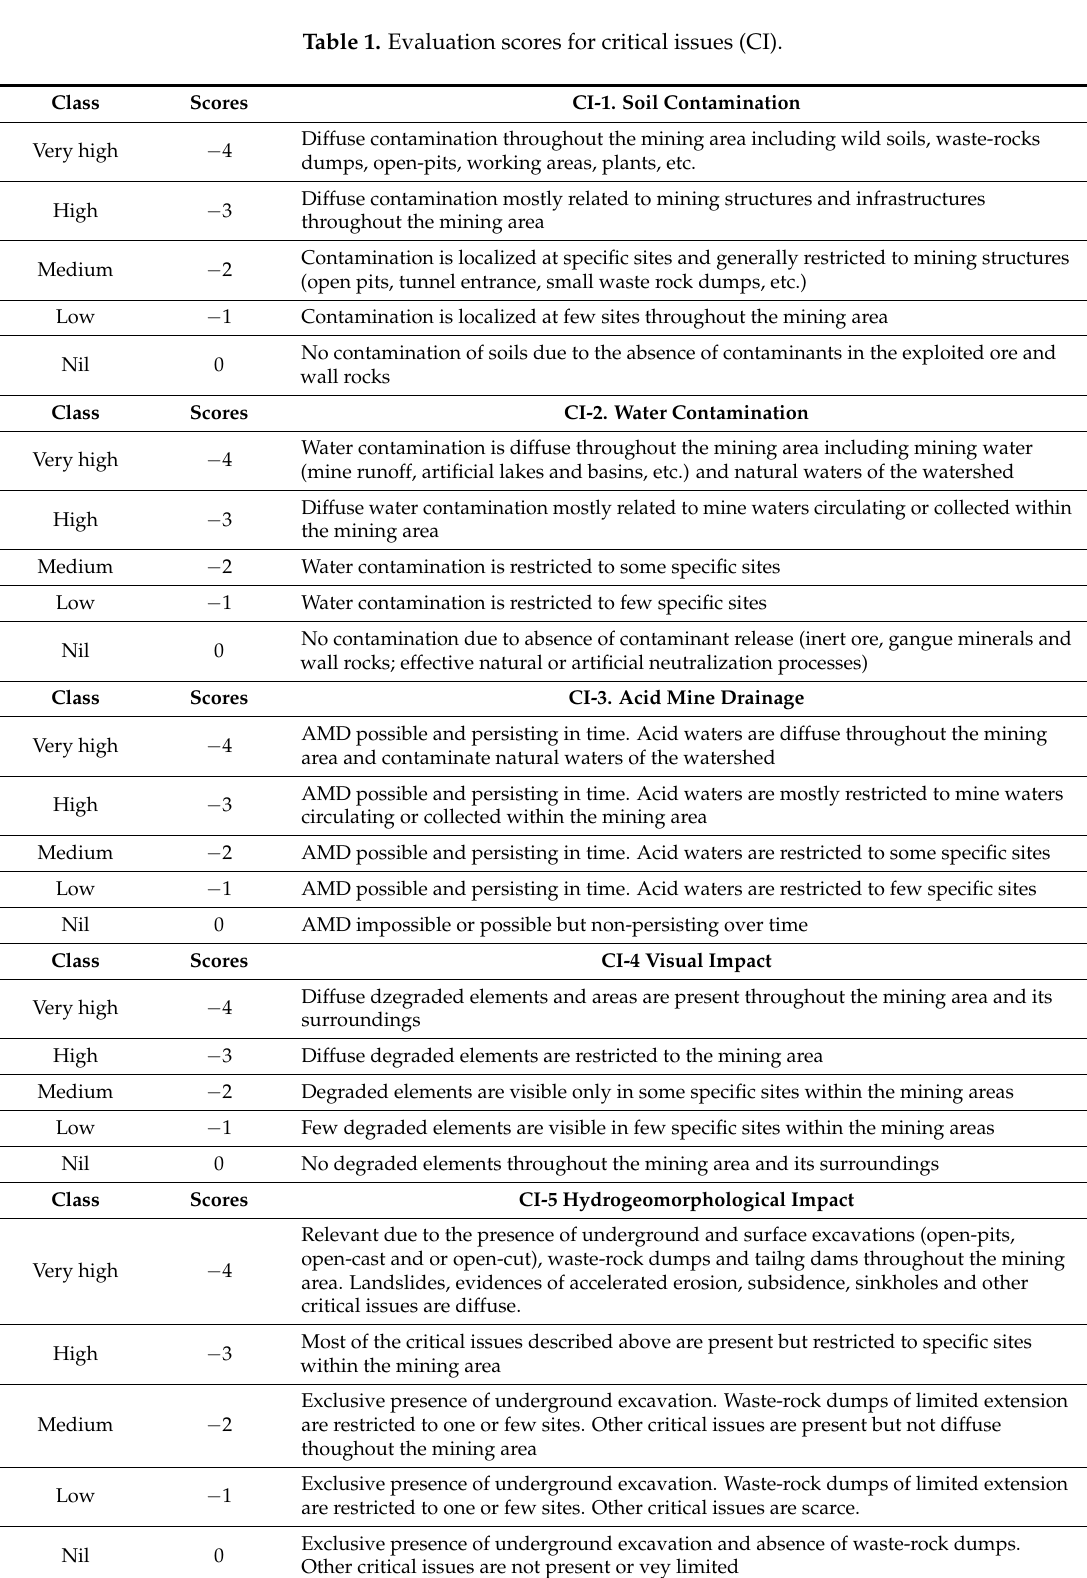
Table 1. Evaluation scores for critical issues